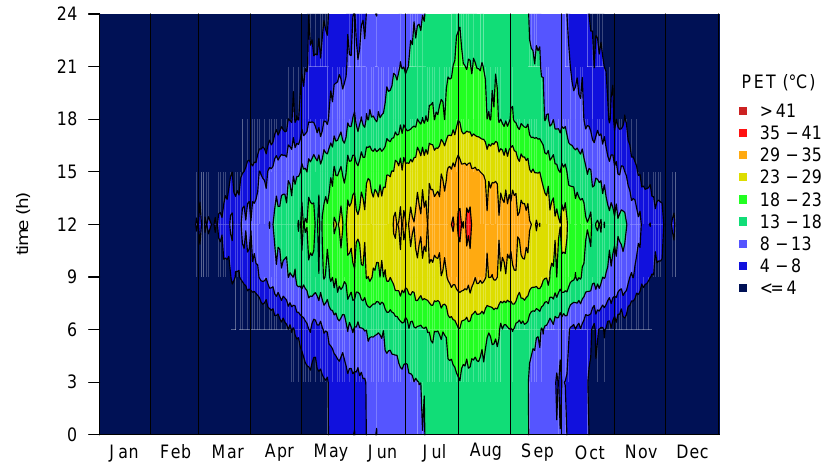
Figure 4. Temporal diagram for PET for Sapporo with a temporal resolution of three hours over the period from October 1966 to July 2018. The x -axis represents the months during a year and the y -axis the variation throughout the day. The thermal sensation classification is stated in Table 1.